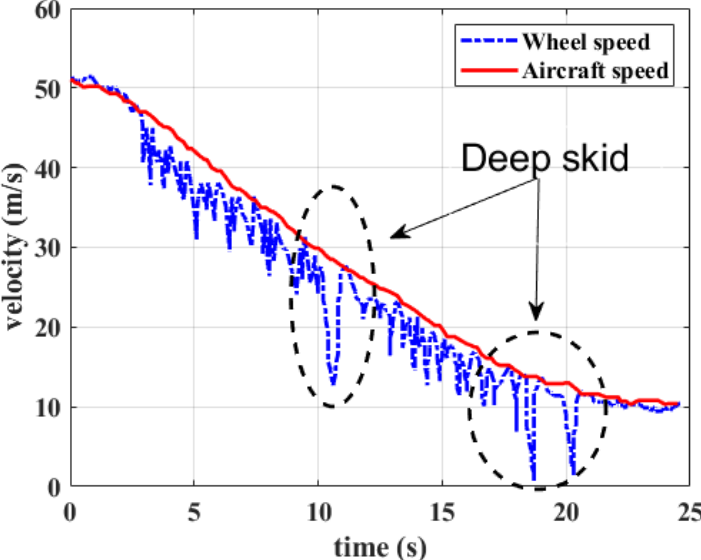
Figure 4. Speed profile of a PBM controller on a slippery